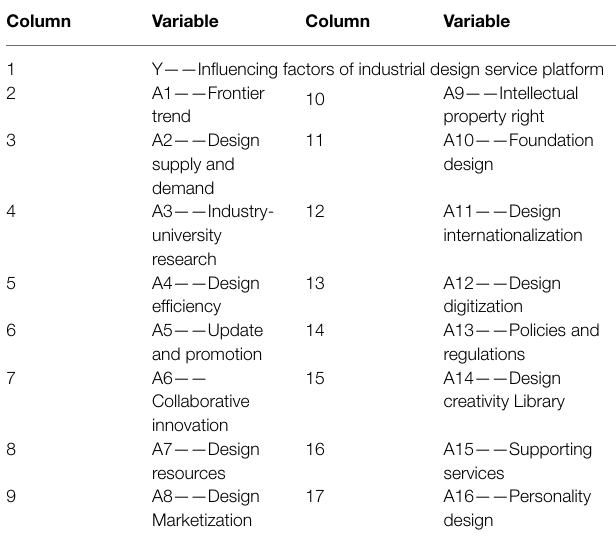
TABLE 4 | Variables represented by each column in the matrix.